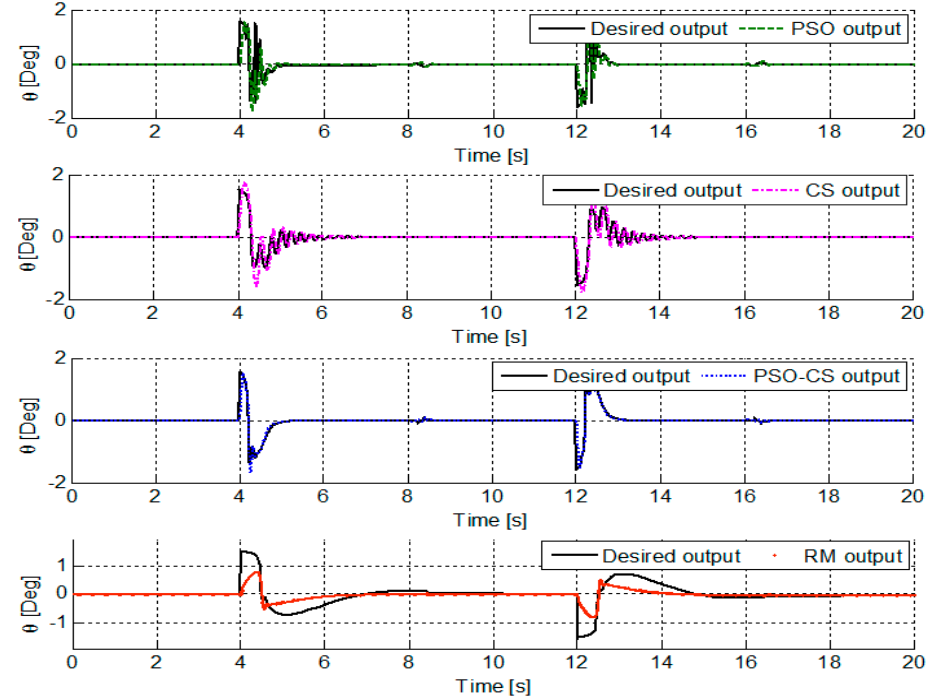
Figure 11. Quadrotor’s pitch attitude ( θ ) using Particle Swarm Optimization (PSO), Cuckoo Search (CS), Particle Swarm Optimization-Cuckoo Search (PSO-CS), and Reference Model (RM) (rectangular trajectory).